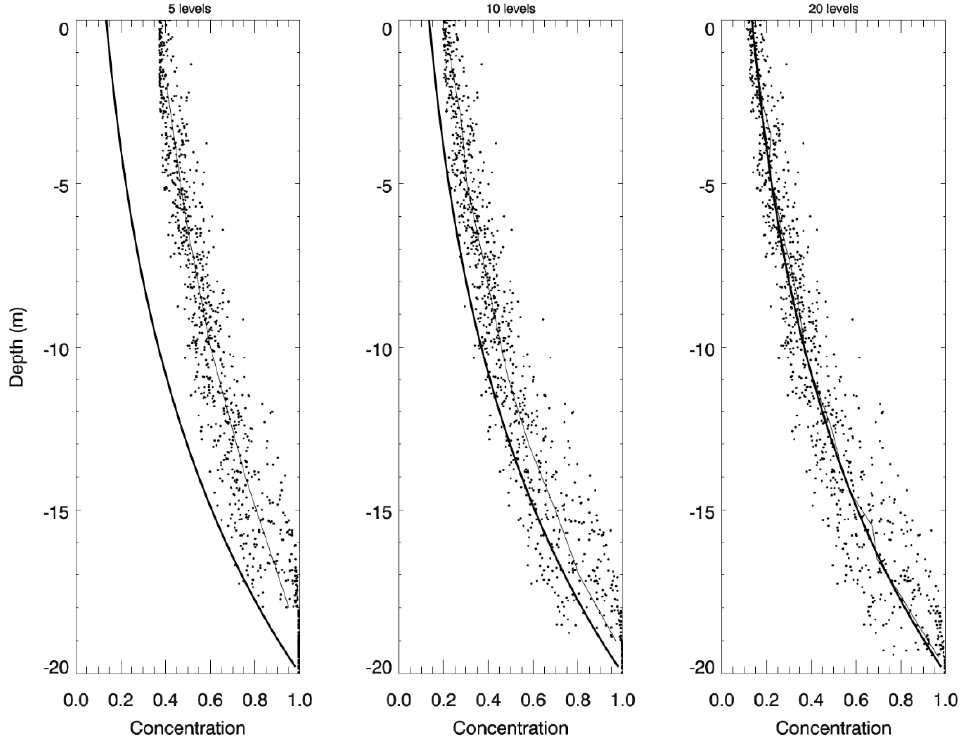
Figure 6. The PCPM simulation of vertical settling in comparison to the analytical solution at the end of 5000 time steps. Three runs were made with 5 ( left panel), 10 ( middle panel), and 20 ( right panel) vertical cells, respectively. The dots represent the locations of the particles on the vertical axis with their respective concentration on the horizontal axis. The thin line represents the cell average concentration and the thick line represents the analytical solution.